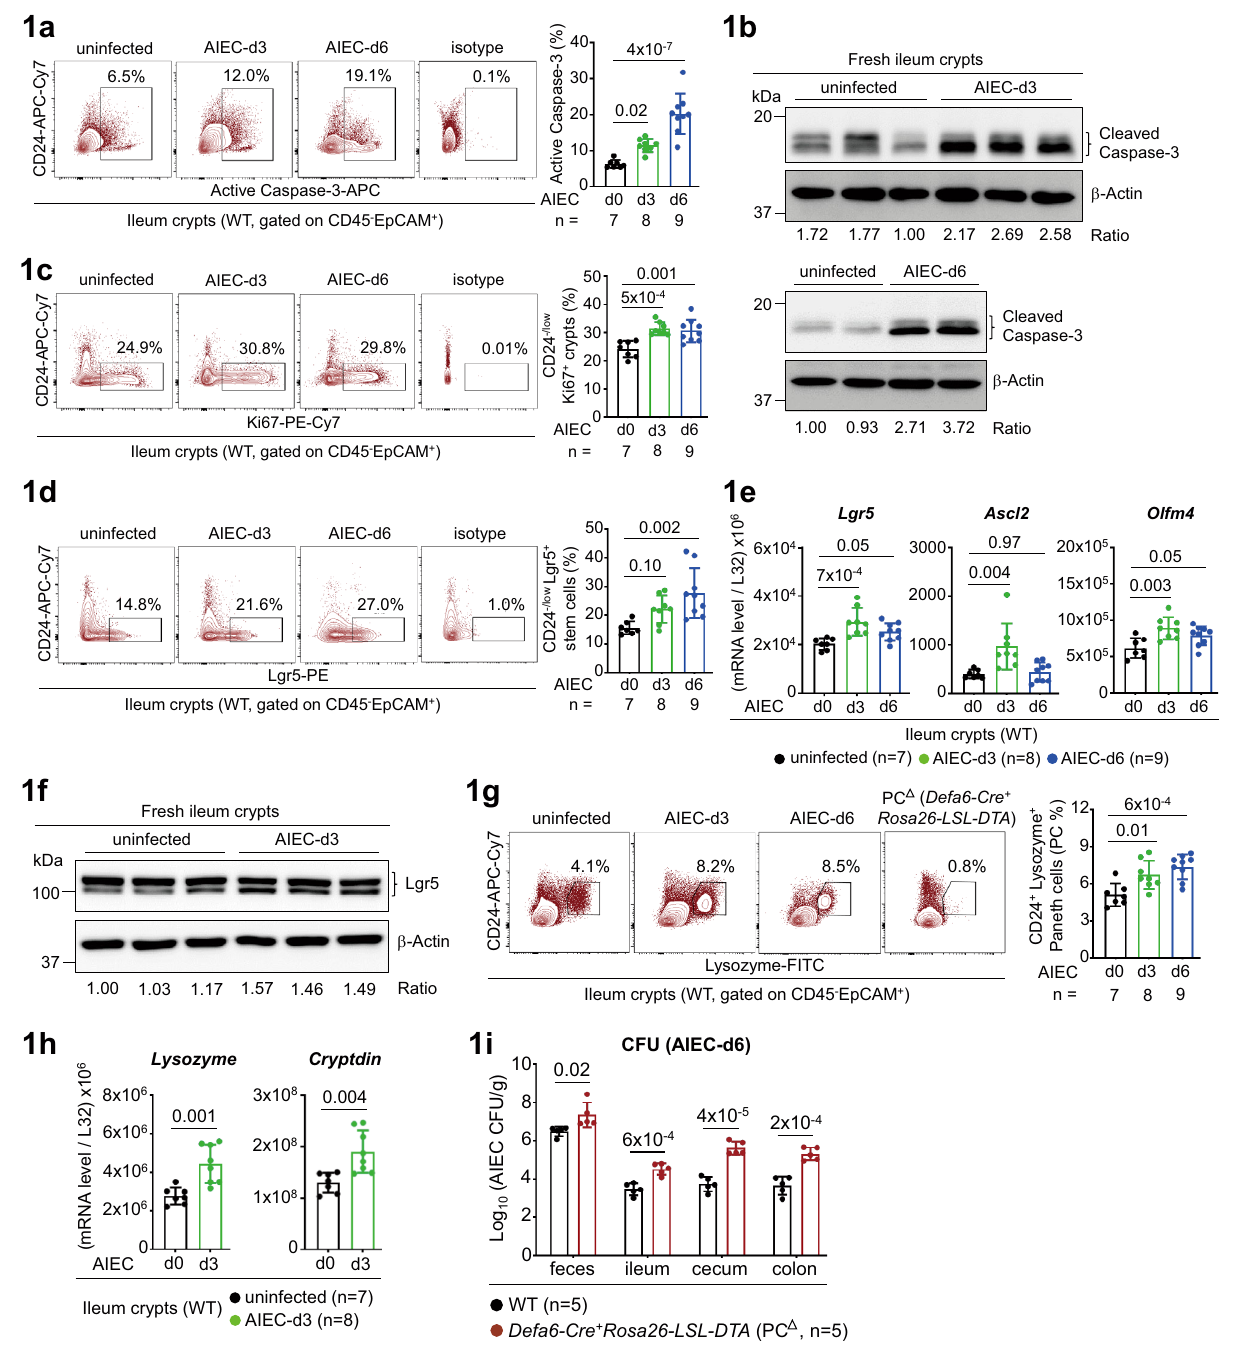
Fig. 1 Crohn ’ s AIEC induces an early response of stem cells and Paneth cells. a Flow cytometry analysis of CD45 - EpCAM + ileum crypts for active Caspase-3 + apoptotic cells in uninfected and AIEC-infected mice at day-3 (d3) and day-6 (d6) post infection. b Western blot analysis of ileum crypts for active Caspase-3 + apoptotic cells. Quanti fi cation and the ratio (Caspase-3 to β -actin) of protein bands are indicated. c Flow cytometry analysis of CD24 -/low ileum crypts for Ki67 + proliferating cells in uninfected and AIEC-infected mice at d3 and d6. d Flow cytometry analysis of CD24 -/low ileum crypts for Lgr5 + stem cells in uninfected and AIEC-infected mice at d3 and d6. e Quantitative real-time PCR analysis of ileum crypts for stem cell marker Lgr5, Ascl2, and Olfm4 in uninfected and AIEC-infected mice. f Western blot analysis of ileum crypts for stem cell marker Lgr5 in the indicated mice. Quanti fi cation and the ratio (Lgr5 to β -actin) of protein bands are indicated. g Flow cytometry analysis of CD24 + ileum crypts for Lysozyme + Paneth cells in the indicated mice. Ileum crypts isolated from Paneth cell-de fi cient (PC Δ ) Defa6-Cre + Rosa26-LSL-DTA mice were used to gate the Paneth cell population. h Quantitative real-time PCR analysis of ileum crypts for Paneth cell marker Lysozyme and Cryptdin in the indicated mice. i Colony-forming unit (CFU) of AIEC was analyzed in feces and intestinal tissues isolated from the indicated mice at d6 post AIEC infection. Each symbol in bar graphs represents an ileum crypt sample ( a , c , d , e , g , h ) or tissue sample ( i ) derived from one mouse. Data shown are representative ( b , f , i ) or combined ( a , c , d , e , g , h ) results from two independent reproducible experiments. Statistical signi fi cance is indicated using unpaired two-tailed t test ( h , i ) or One-way ANOVA with Sidak ’ s multiple comparisons test ( a , c , d , e , g ). Data are presented as mean ± SD. Source data are provided as a Source Data fi